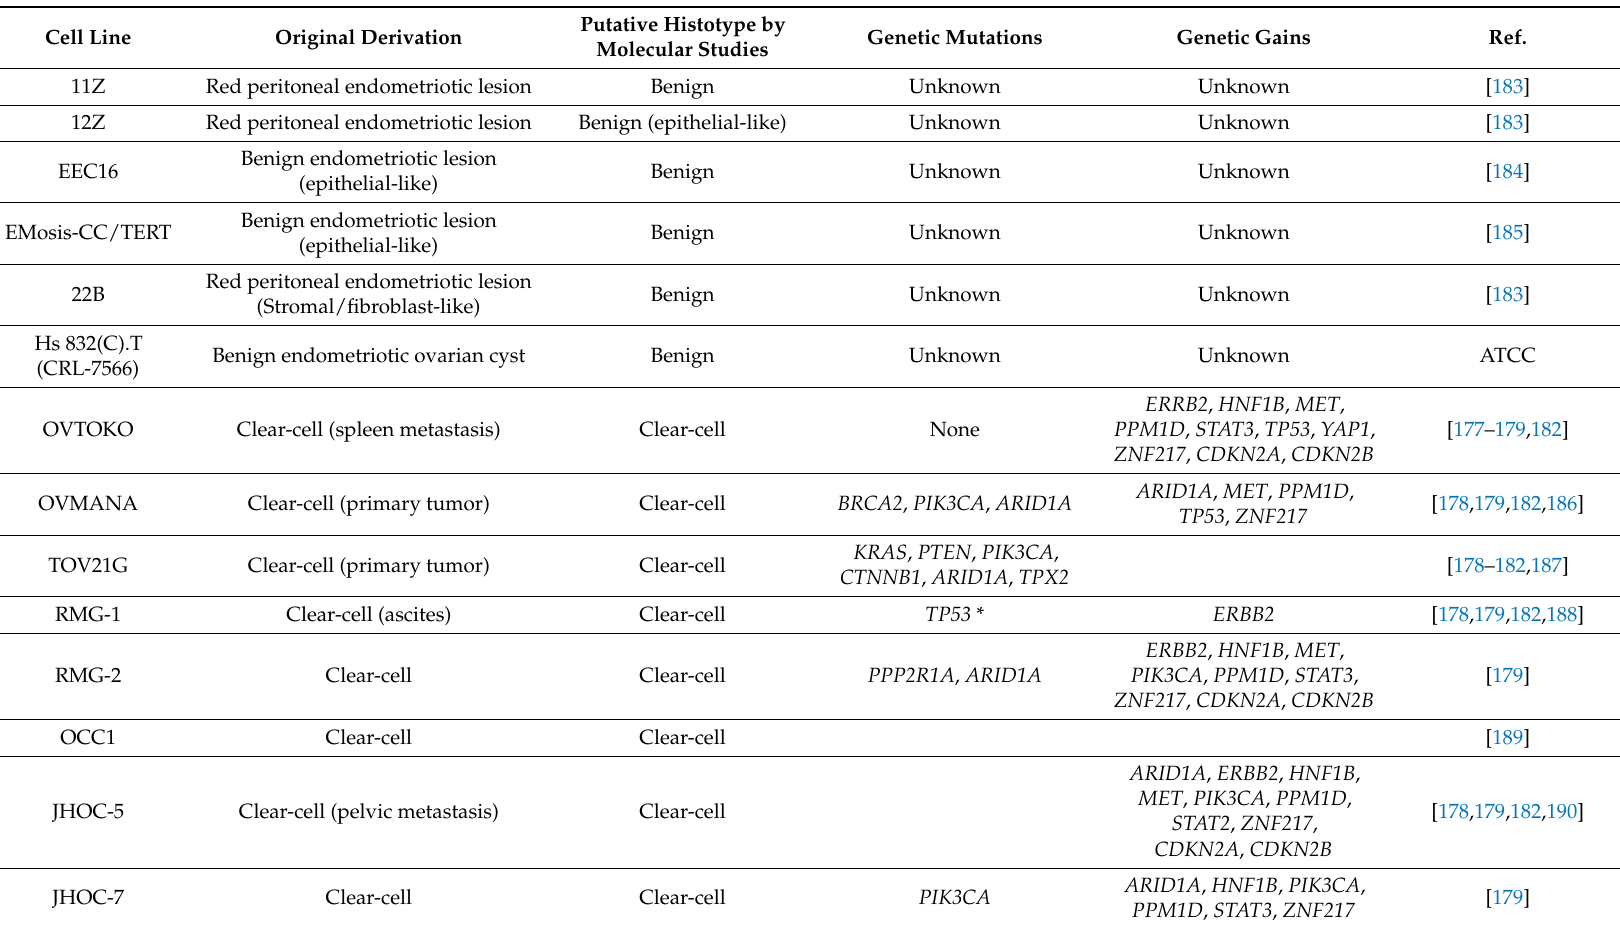
Table 4. Endometriosis and endometriosis-associated ovarian cancer cell